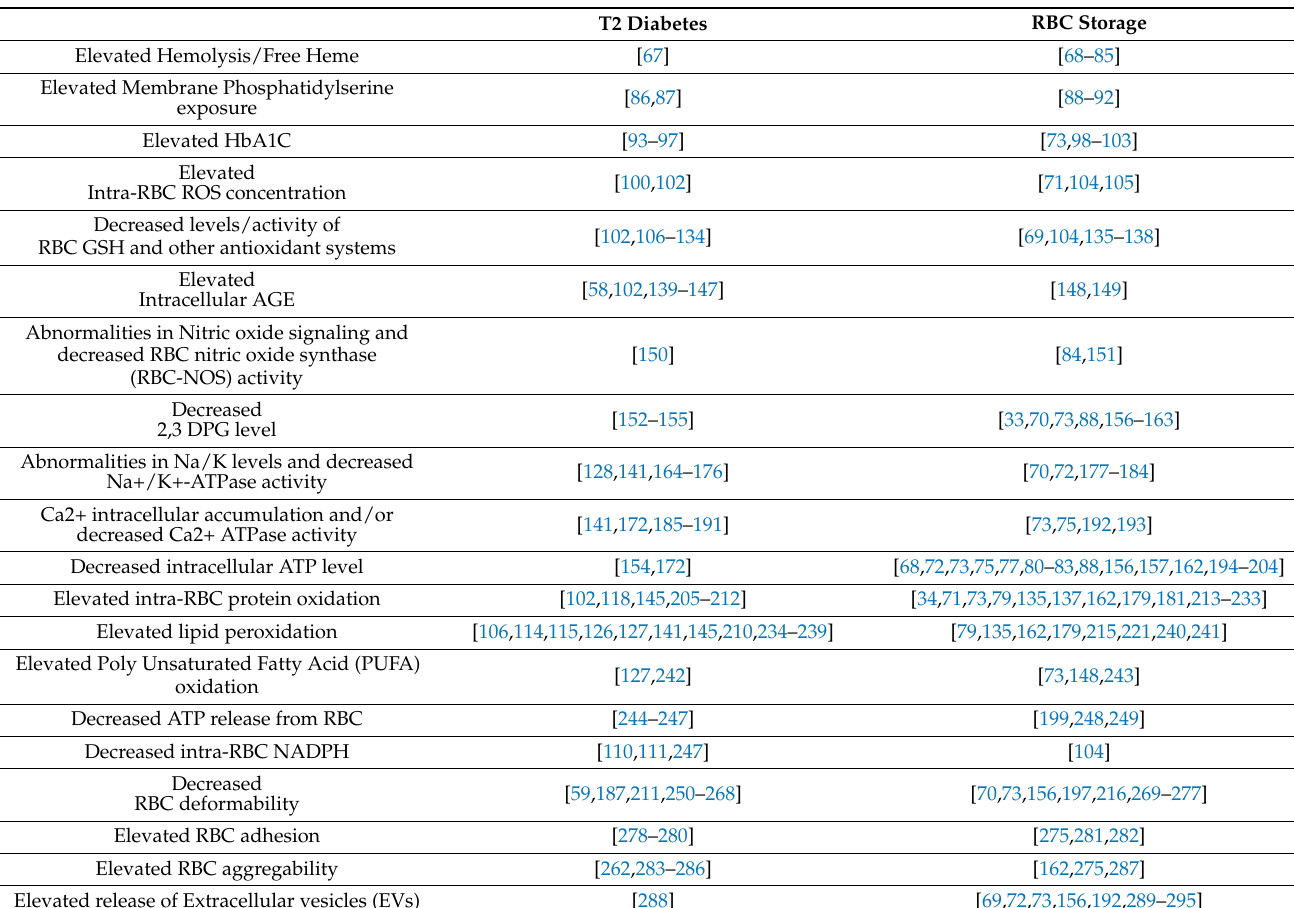
Table 1. Comparison between some features of RBC from non-insulin-dependent diabetic patients and stored units. T2